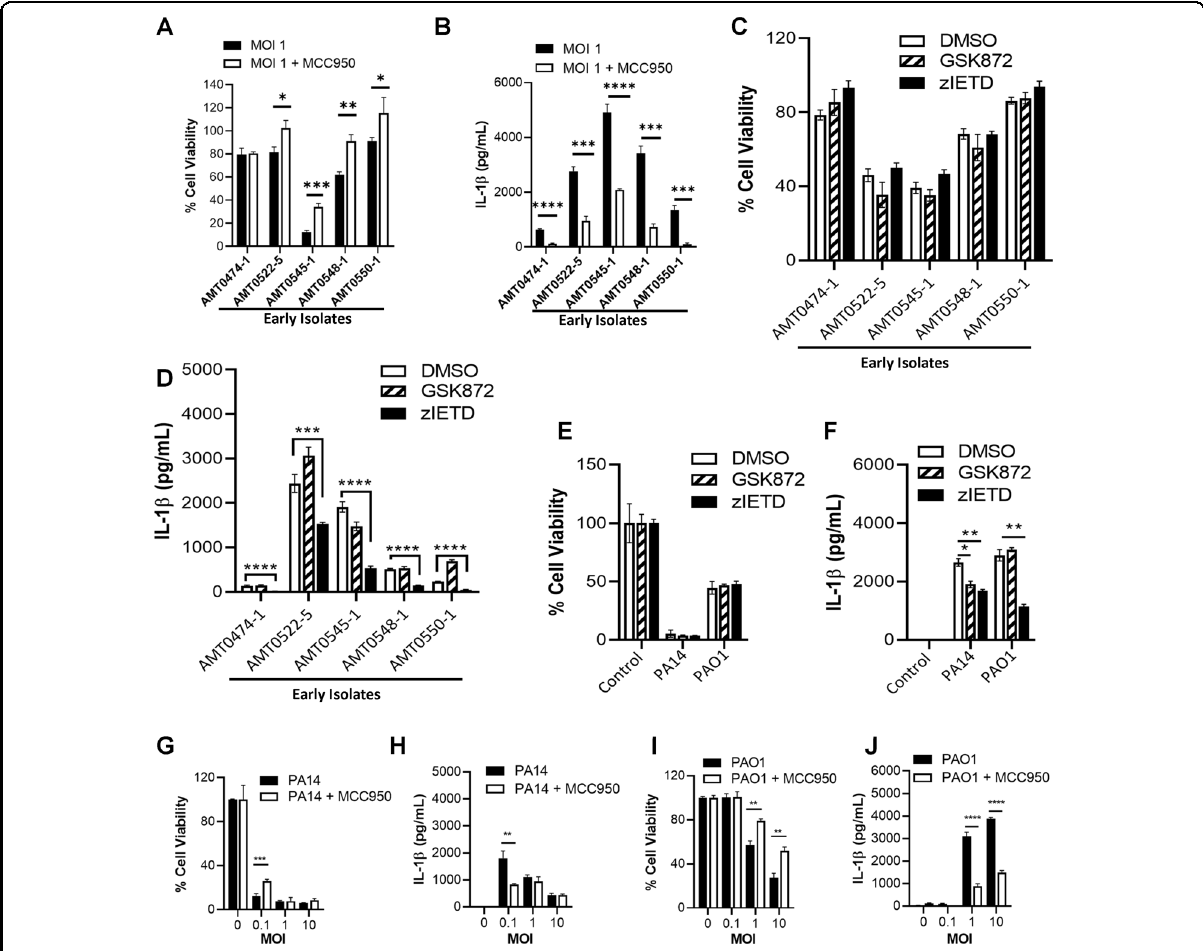
Fig. 3 Early CF infection P. aeruginosa isolates and PAO1 are partially dependent on NLRP3 to induce cell death and IL-1 β production. THP- 1 macrophages were seeded as described in Fig. 1. THP-1 macrophages were treated with 10 µM of MCC950 at the time of infection with early P. aeruginosa isolates from CF patients and the indicated laboratory reference strains to inhibit NLRP3 activation when infecting THP-1 macrophages. At 3 h postinfection, cell viability was evaluated by neutral red assay ( A , G , I ) and IL-1 β production was measured in cell supernatants by ELISA ( B , H , J ). THP-1 macrophages were seeded as described in Fig. 1 and pre-treated with 5 µM GSK872 (RipK3 inhibitor), 10 µM z-IETD-FMK (caspase-8 inhibitor) or a DMSO control 2 h prior to infection. Respective treatments were continued during THP-1 macrophage infections with indicated early P. aeruginosa isolates or reference strains (1 MOI). At 3 h postinfection, cell viability was evaluated by neutral red assay ( C , E ) and IL-1 β production was measured in cell supernatants by ELISA ( D , F ). Mean ± SD of experimental triplicates are shown. Student ’ s t -tests ( A , B , G – J ) and one-way ANOVAs followed by Dunnett ’ s multiple comparisons tests ( D , F ) were conducted. Mean ± SD of triplicates of a representative experiment are shown. (* P < 0.05, ** P < 0.01, *** P < 0.001, **** P <